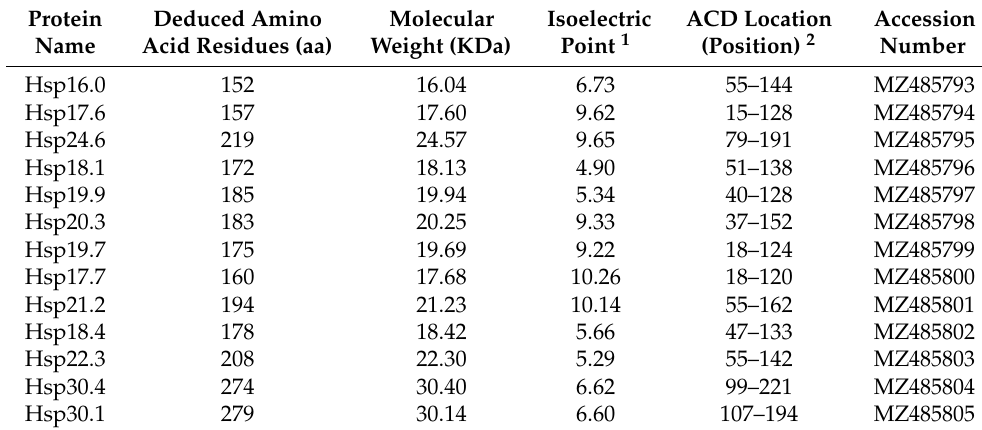
Table 1. Characterizations of identified sHsp sequences from dinoflagellate-specific e-cDNA